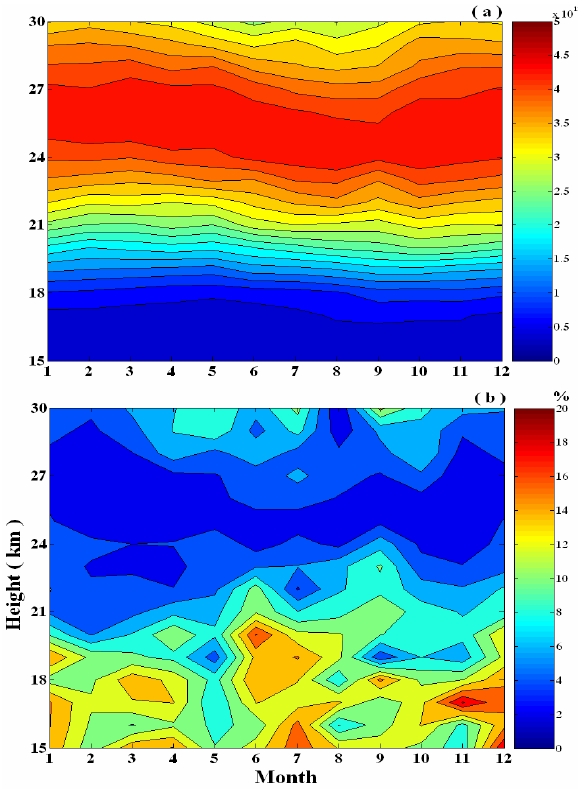
Fig. 4. (a) Height-Month-mean ozone concentration plot and (b) FIGURE – 4: percentage of deviation obtained from ozonesonde measurements. (a) Height-Month-mean ozone concentration plot and (b) percentage of deviation The percentage of deviation is the ratio between the obtained stan- obtained from ozonesonde measurements. The percentage of deviation is the ratio dard deviation and the respective monthly mean between the obtained standard deviation and the respective monthly mean value.